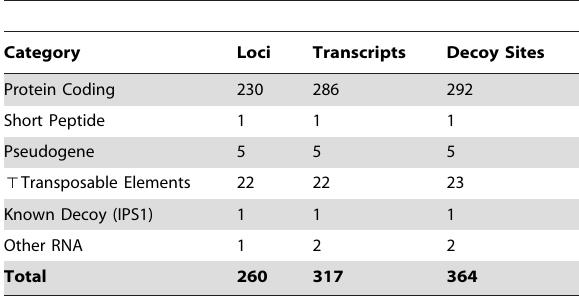
Table 1. Distribution of predicted decoys in functional